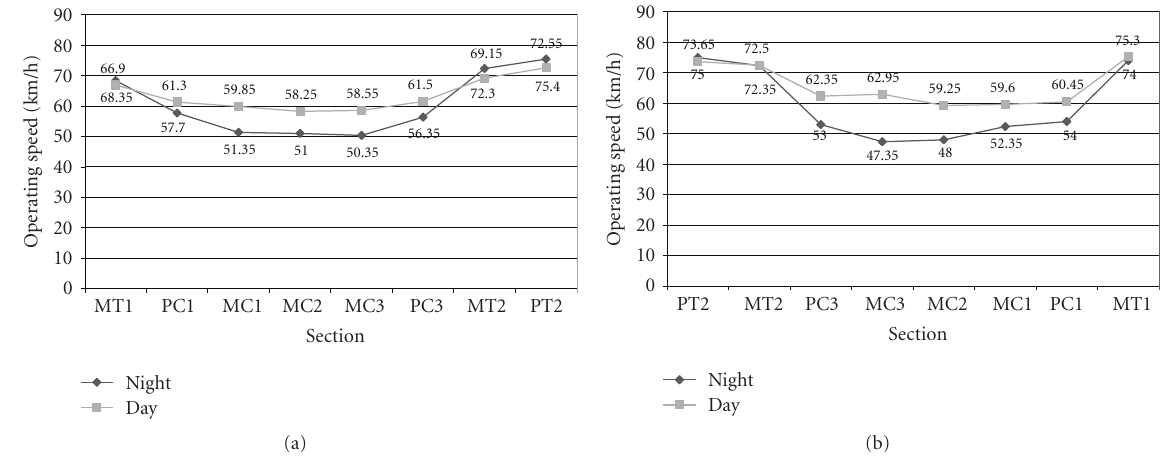
Figure 9: Night/day operating speed (S 85 , km/h), eastwards (a) and westwards (b), in virtual environment.